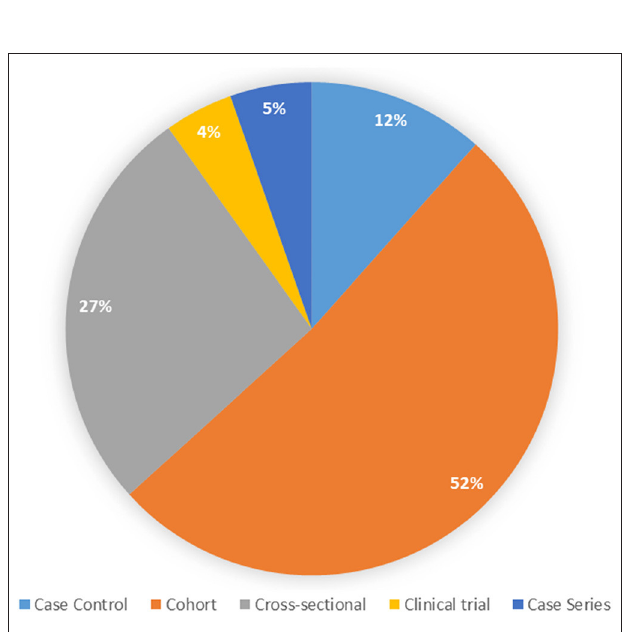
FIGURE 4 | Types of study designs.